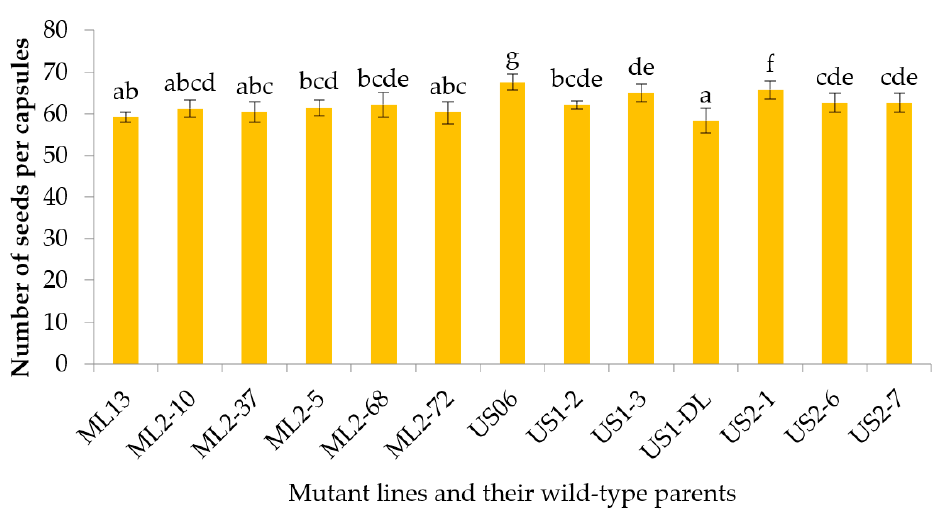
Figure 8. Number of seeds per capsules (NSC) in 11 sesame mutant lines and their two wildtypes (US06 and ML13). The superscript letters represent the groups according to Duncan’s test.